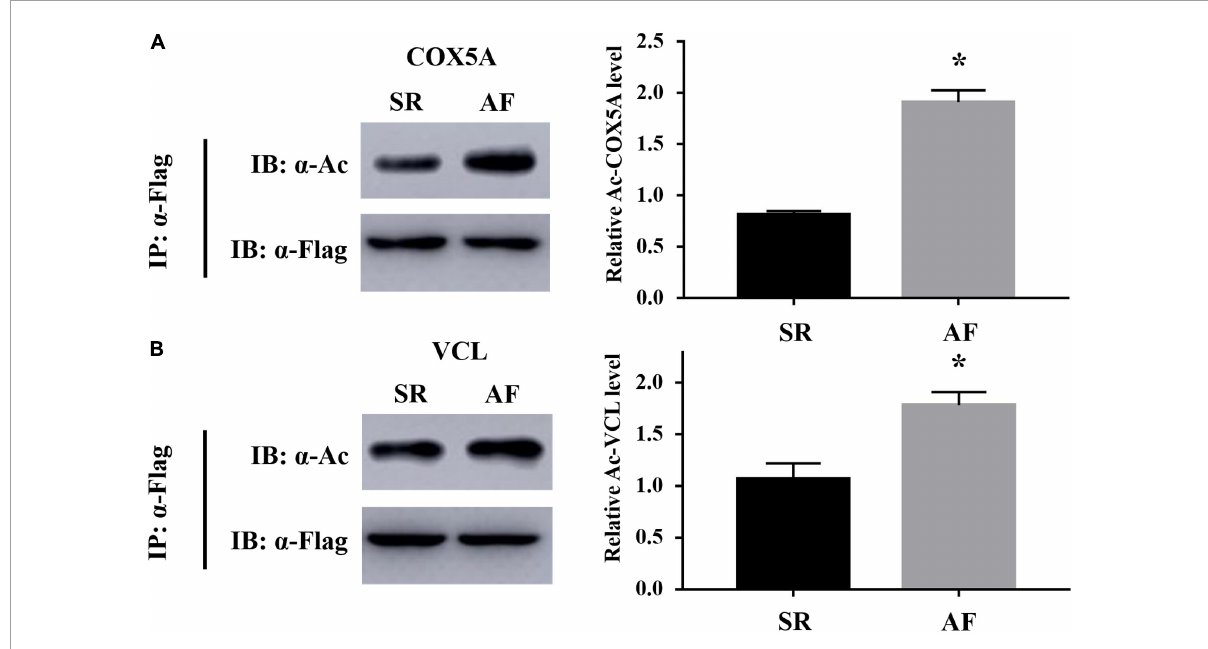
FIGURE10 Validation results of acetylated COX5A and acetylated VCL by co-immunoprecipitation (Co-IP) combined with Western blotting (WB). (A) Acetylated COX5A. (B) AcetylatedVCL. IP, immunoprecipitation; IB, immunoblotting; COX5A, cytochrome c oxidase subunit 5A, mitochondrial; VCL, vinculin. * P <